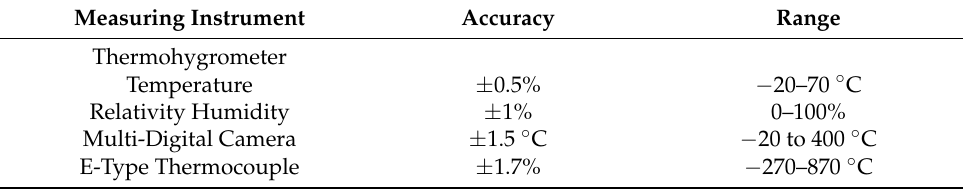
Table 1. Cont. Measuring